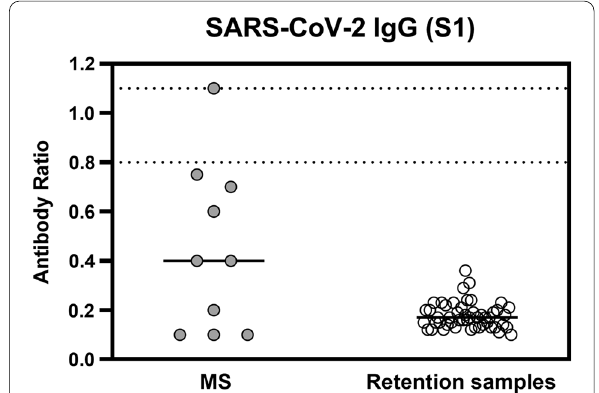
Fig. 3 SARS-CoV-2 specific IgG responses in 10 patients with multiple sclerosis (MS) and 50 retention samples from 2016. Horizontal bold lines indicate median values, the dotted lines lower and upper limit of borderline responses (ratio of 0.8 and